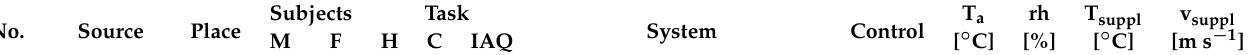
Table A2. Personal climatization systems applying horizontal and vertical